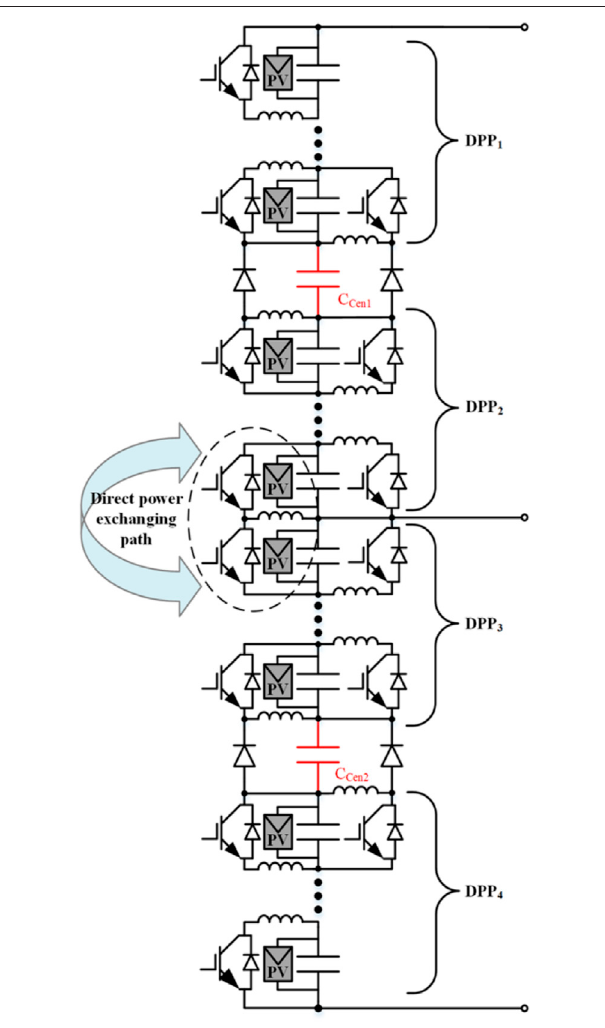
FIGURE 8 | Extended con fi guration of the TICC converter where four PV-to-PV DPP converters are embedded.